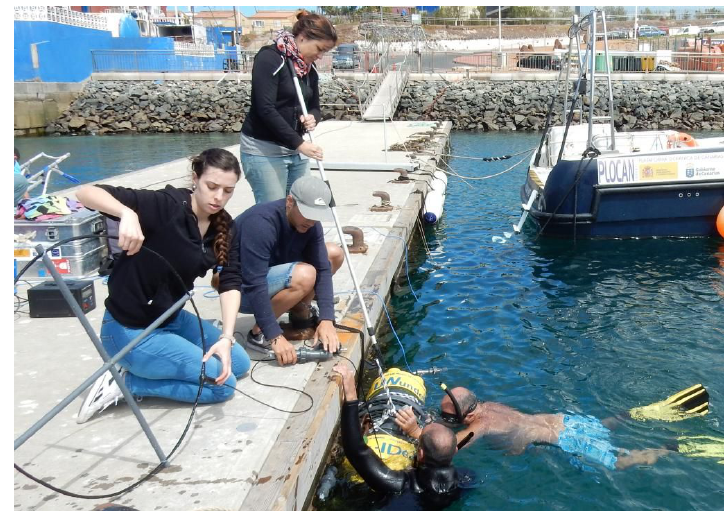
Figure 5. Launching